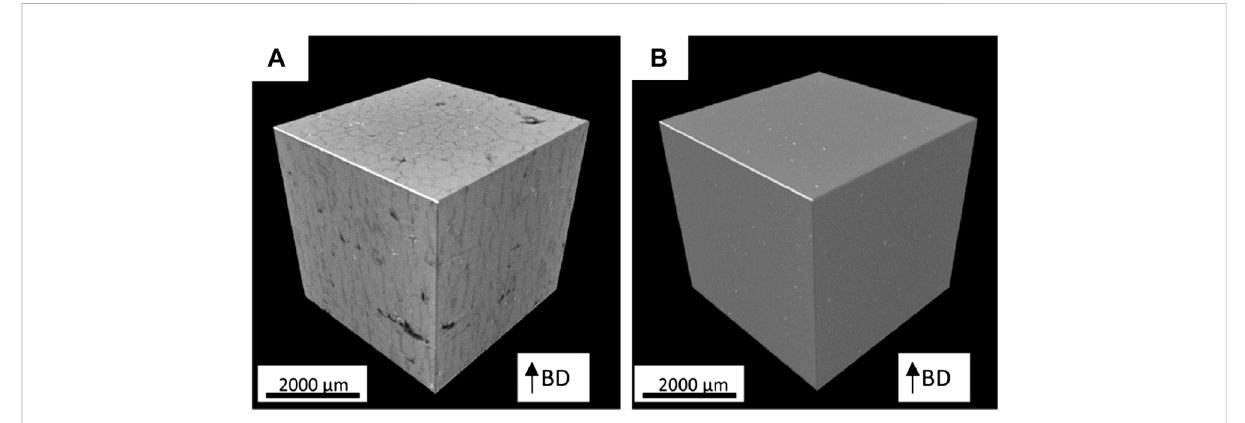
FIGURE 12 X-ray microscopy (XRM) images of (A) a specimen built from non-functionalized Al 2024; and (B) a specimen built from Al2024 powder dry coated with